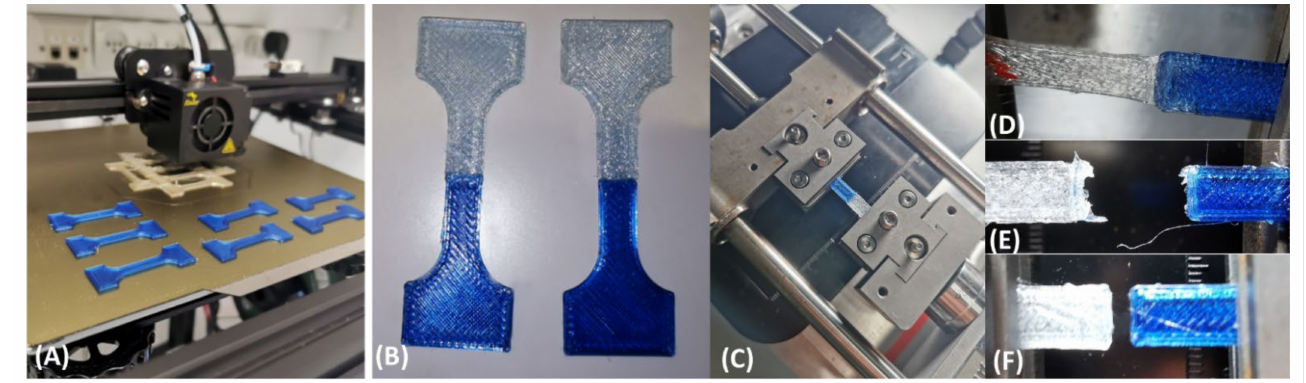
Figure 2. ( A ) The 3D printing of dog bones. ( B – F ) Combined stiff (PETG, blue) and compliant (TPU, white) samples after printing ( B ) under tensile testing and failure testing ( C – F